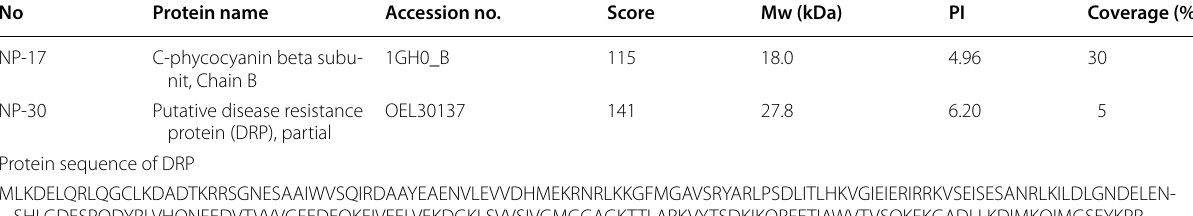
The underlined amino acid sequence is identified by MS/MS and to be the 5% coverage of DRP